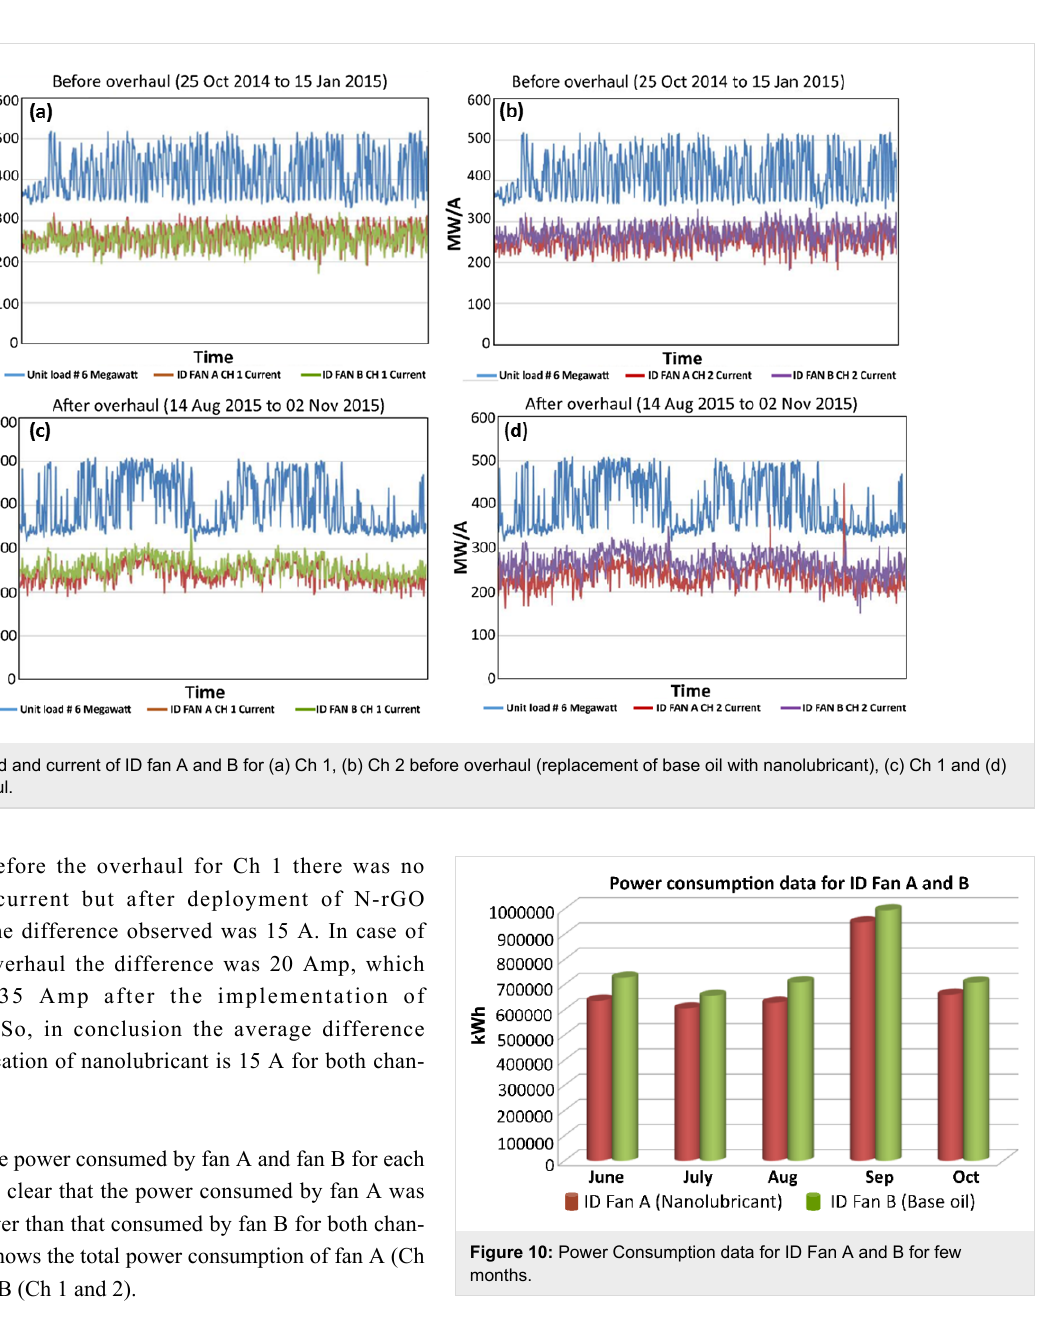
Table 1: Power consumption of ID fans A and B over several months.